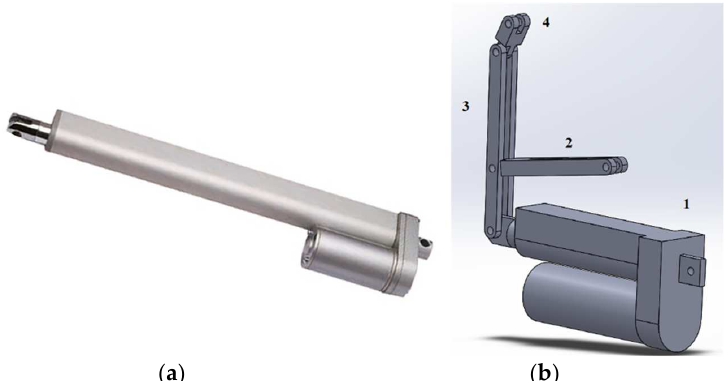
Figure 3. ( a ) Actuator and ( b ) mechanism used to move the DRS system. Rods 2, 3, and 4 transform linear motion into circular